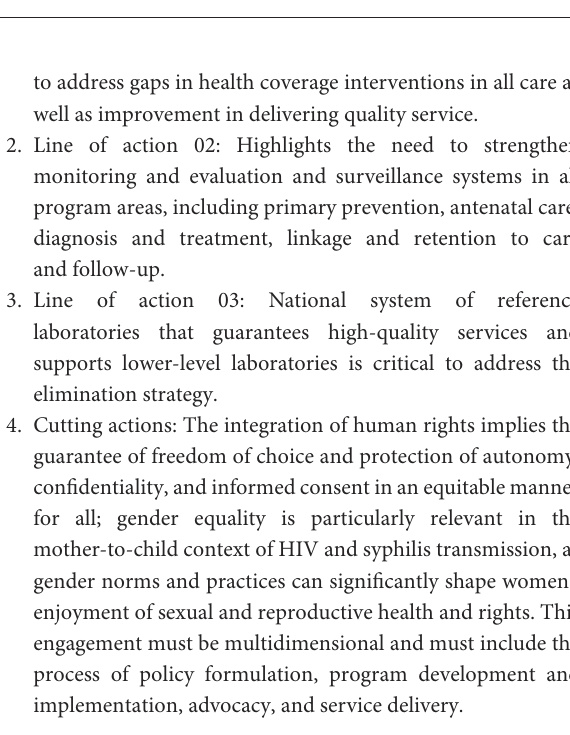
FIGURE1 Strategic directions for eliminating sexually transmitted infections. Source: Adapted from WHO